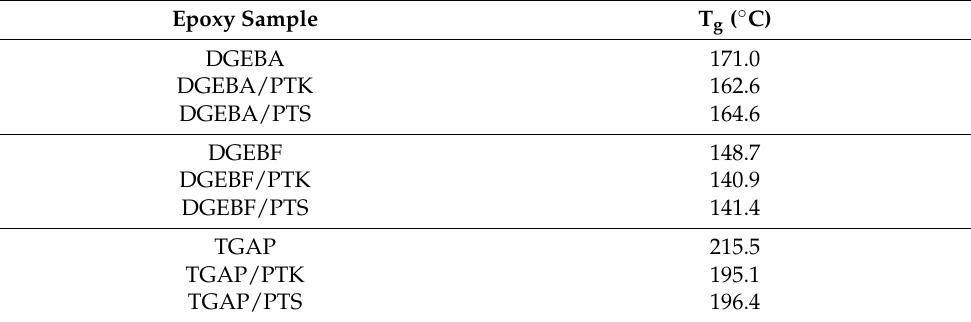
Table 2. Glass transition temperatures (T g s) of the prepared samples.